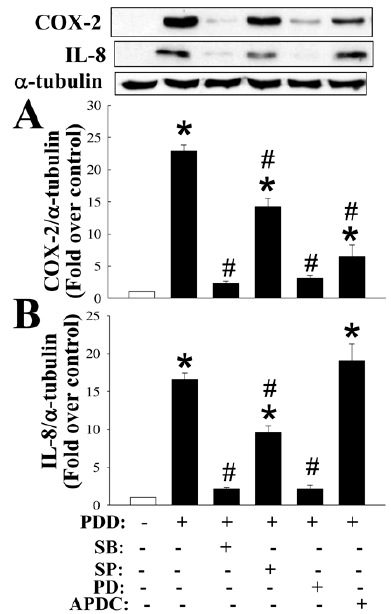
Figure 6. Identification of the signaling pathway(s) mediating PKC-induced COX-2 and IL-8 expression. Plated KGN cells were pretreated with mitogen-activated protein kinases (MAPKs) inhibitors individually (SB: p38 inhibitor, 20 µ M; SP: c-Jun N-terminal kinase (JNK) inhibitor, 40 µ M; PD: extracellular signal-regulated kinase (ERK) inhibitor, 20 µ M), or nuclear factor kappa-light-chain-enhancer of activated B cells (NF- κ B) inhibitor ammonium pyrrolidinedithiocarbamate (APDC, 50 µ M) for 1 h and then PDD (100 nM) was included for an additional 12 h. The intracellular COX-2 ( A ) and IL-8 ( B ) protein expression levels were assessed by Western blotting assay. The results represent the means ± SEM ( n = 4) * p < 0.05 compared with the control; # p < 0.05 compared with the PDD treatment.